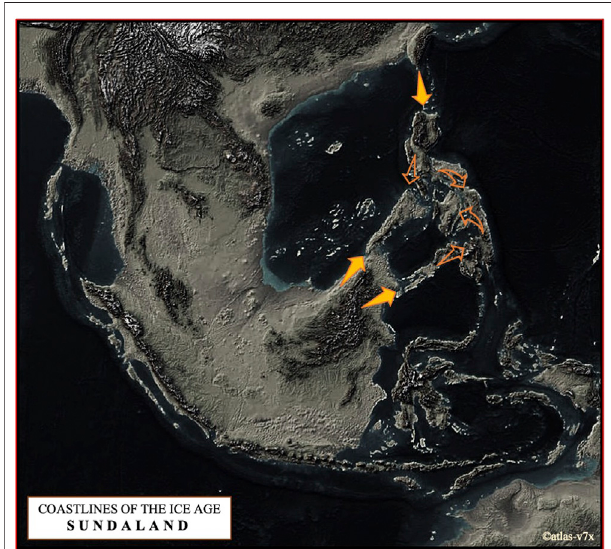
FIGURE 7 | The map shows a terrain that may have been formed during the Last Glacial Maximum about 21,000 years ago, when sea level was about 125 m below the present level (©atlas-v7x). We have proposed here two dispersal routes of pigs to the Philippine Archipelago, one via NEA via Taiwan in parallel with the Neolithic expansion in ISEA and Oceania, and the other via Southeast Asia, especially from the Indochinese Peninsula via Sundaic Region to Palawan and the Sulu